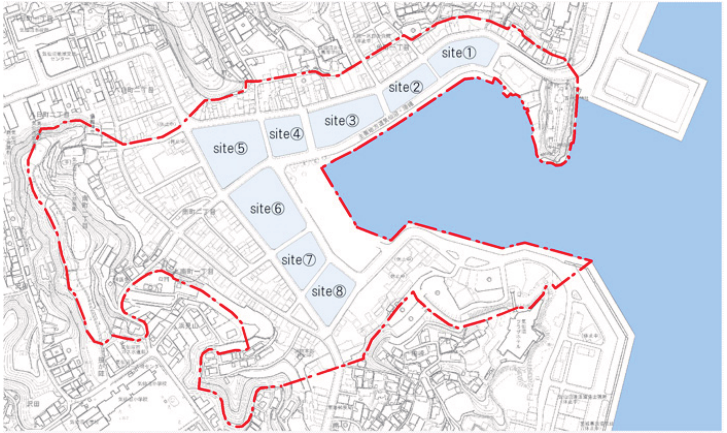
Figure 14. Site plan of eight district blocks in Kesennuma Bay area.